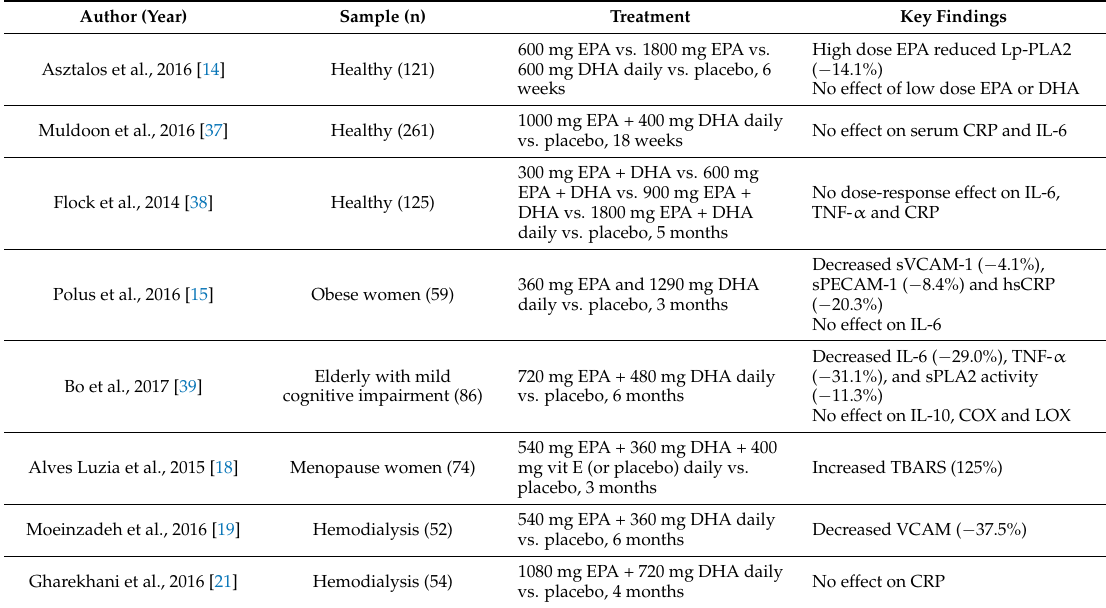
Table 3. Inflammation and oxidative stress in healthy, ageing and chronic renal